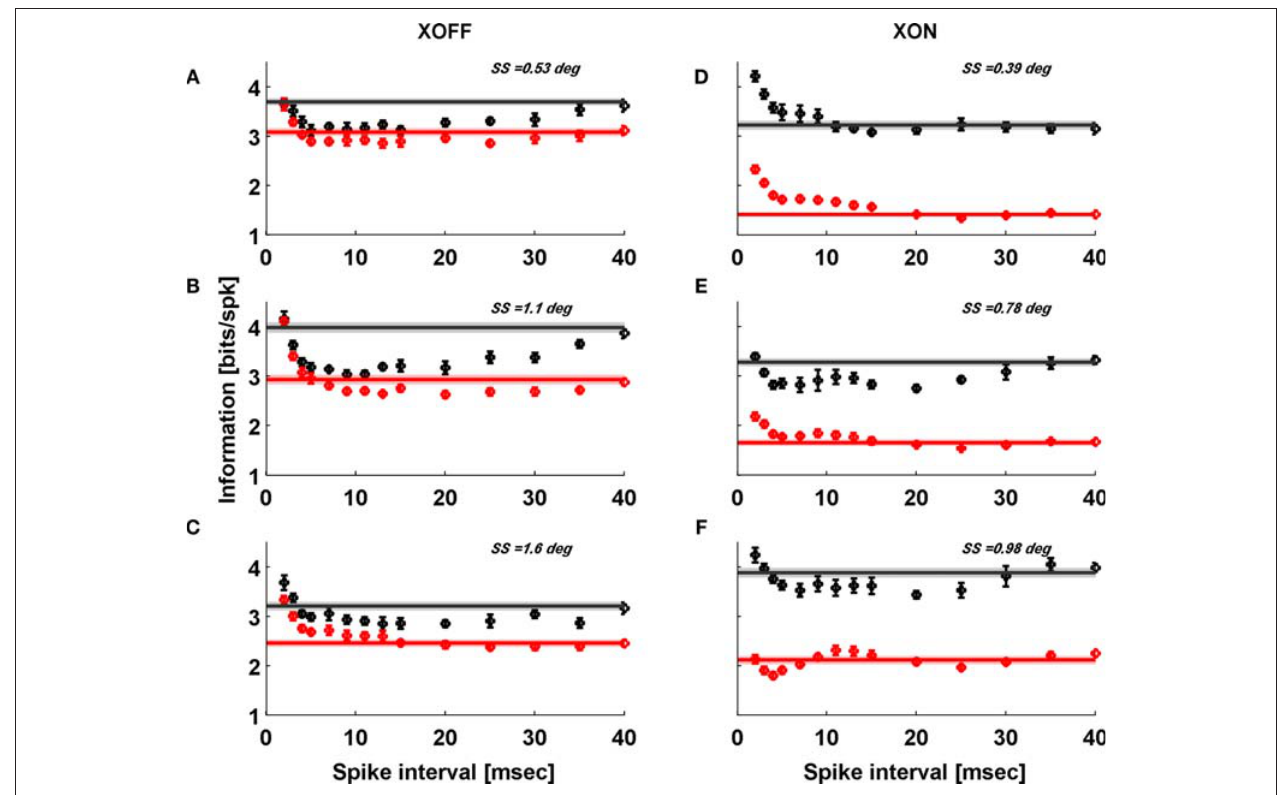
FIGURE 6 | Information contained in pairs of spikes I synergistic at short inter-spike intervals and redundant at longer intervals. The black data points are for LGN and the red are for RGC. The horizontal lines lie at 2 × I which is what we would expect the value of I spike